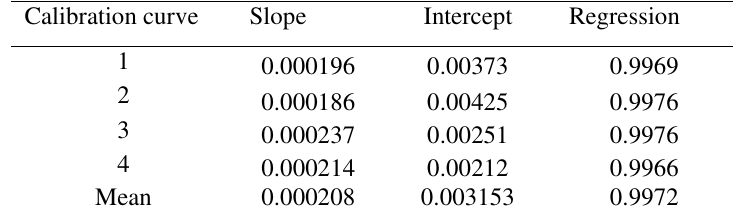
Table 1 . Data of correlation coefficient (r)